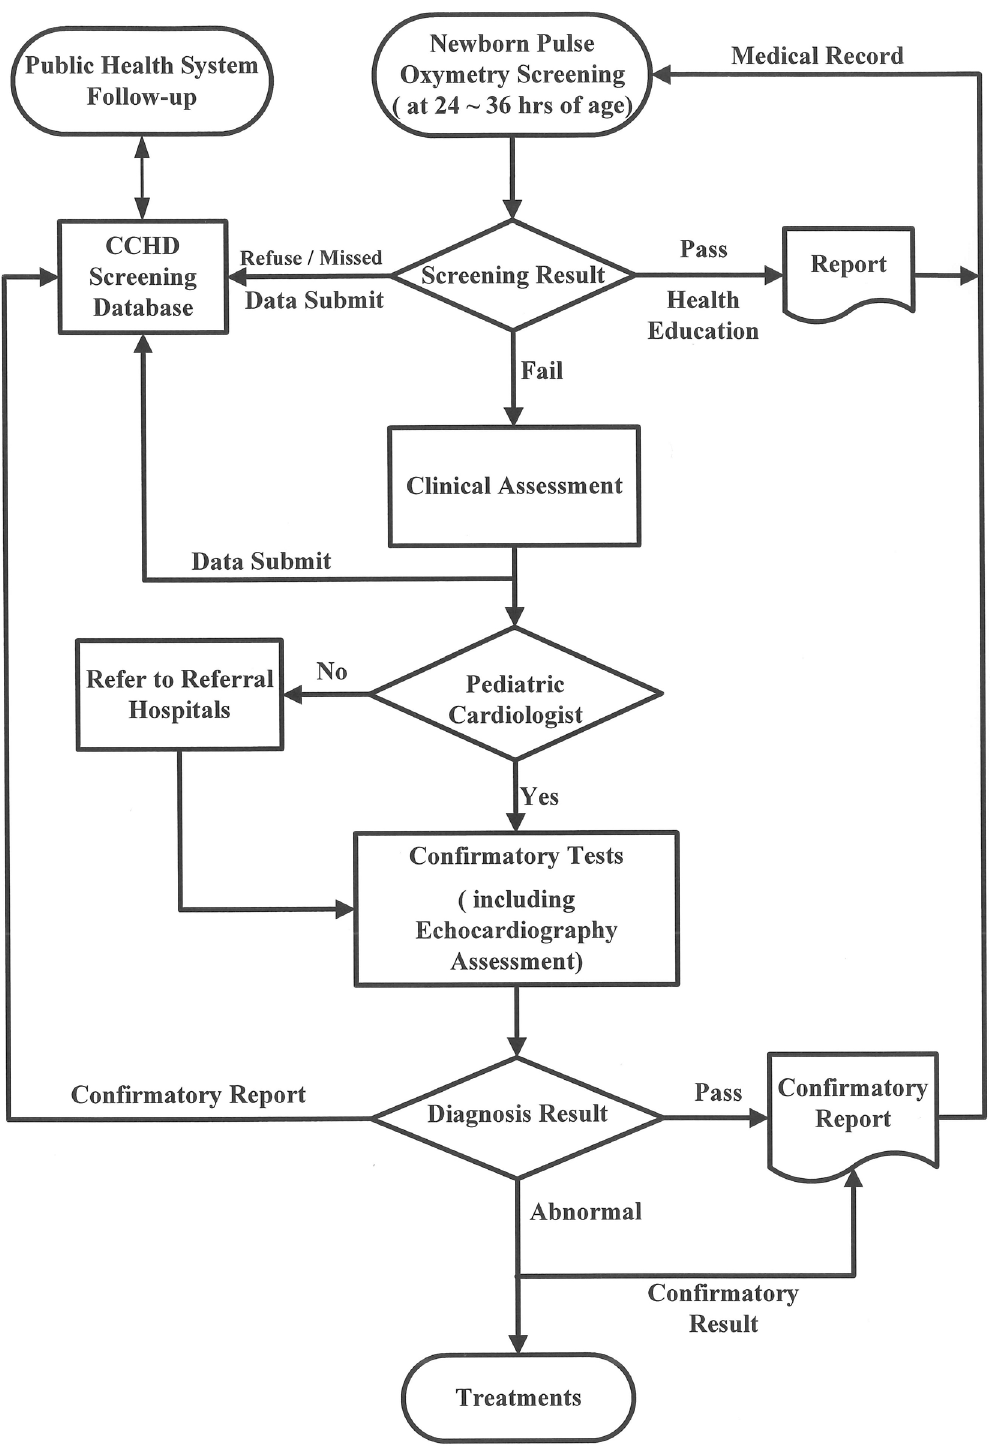
Fig 1. The screening algorithm for CCHD in Taipei. Abbreviation: critical congenital heart disease, CCHD.